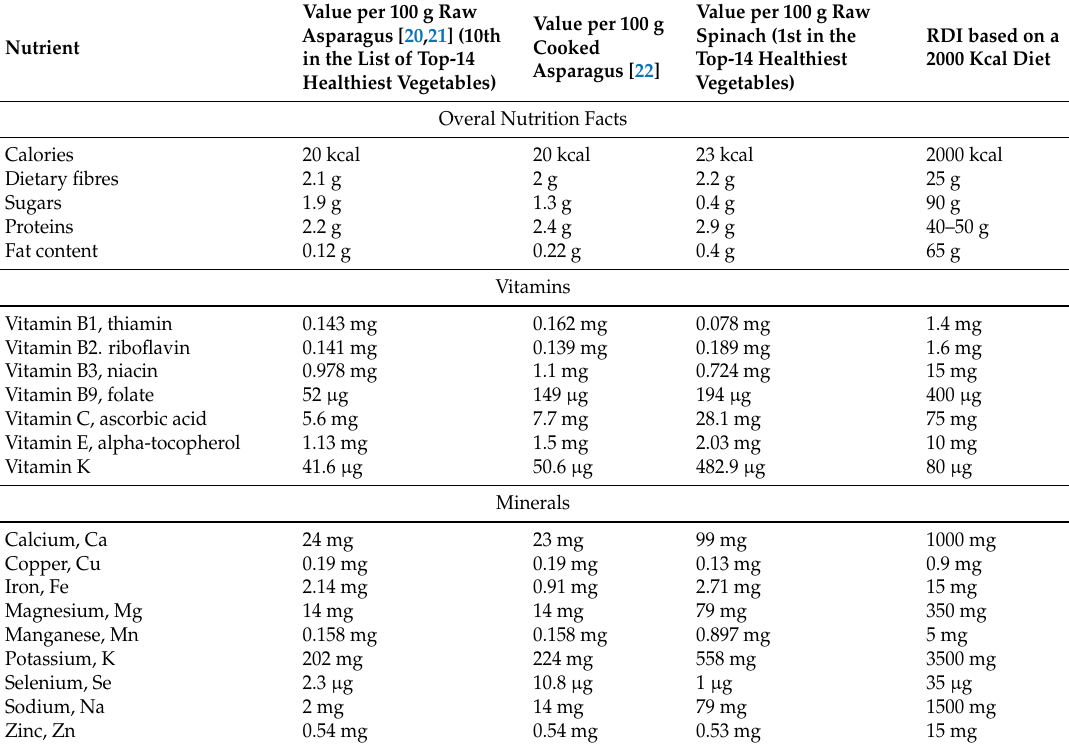
Table 1. Nutritional overview of raw and cooked asparagus (100 g) and for reference, the Recommended Daily Intake (RDI) of the nutrients based on a 2000 kcal diet. Indicated are also the values of the listed nutrients present in spinach considered as the No. 1 of the 14 healthiest vegetables in the world [19].